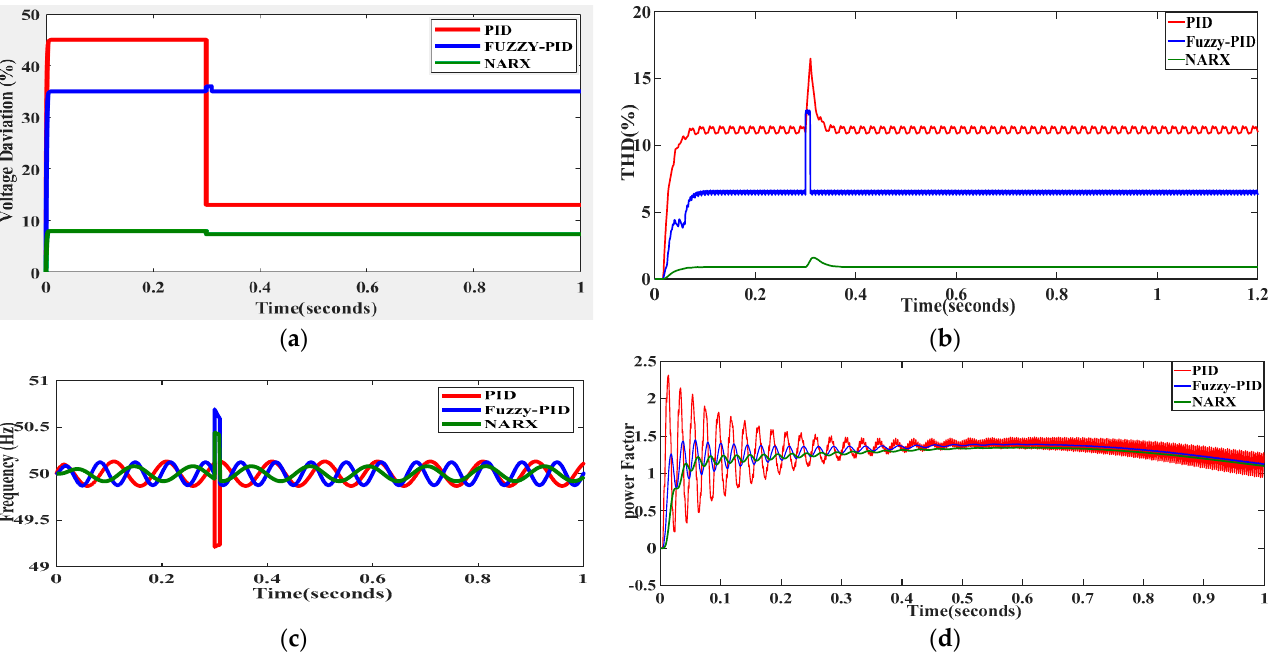
Figure 11. ( a ). Comparison of micro-grid voltage deviation (VD). ( b ) Comparison of micro-grid total harmonic distortion (THD). ( c ) Comparison of micro-grid frequency. ( d ) Comparison of micro-grid Power Factor.